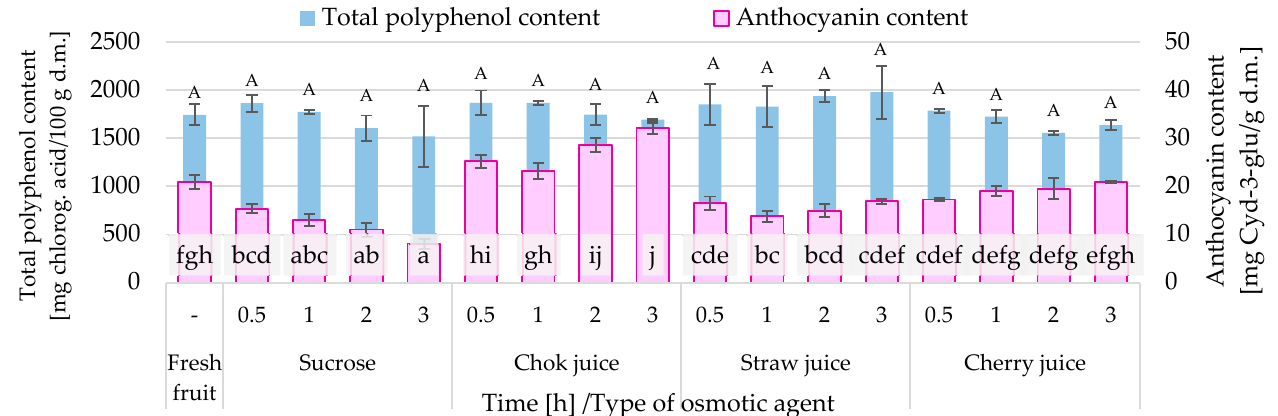
Figure 6. Effect of the type of osmotic agent (sucrose and fruit concentrates) on the total polyphenol content and anthocyanin content in osmodehydrated strawberries. Different letters (small letters are for anthocyanin content, capital letters are for total polyphenol content) above columns show the statistical difference ( p < 0.05).